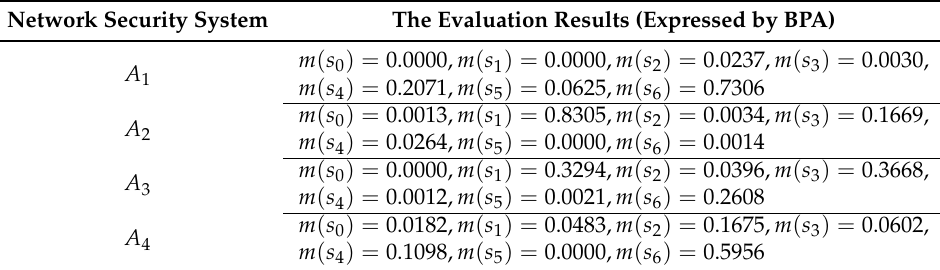
Table 17. The evaluation results (expressed by BPA).